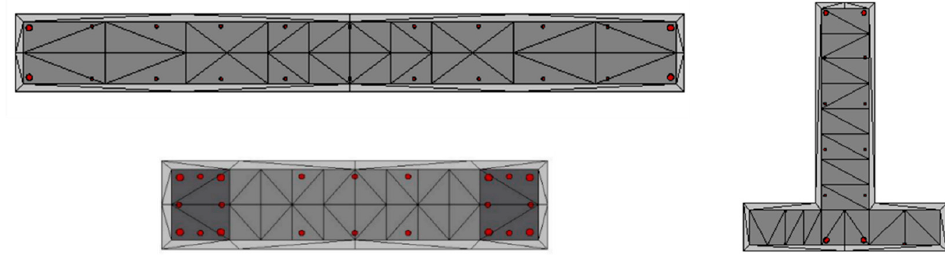
Figure 5. Examples of fiber discretization of shear wall and upturned-beam sections (not to scale, taken from SeismoStruct).